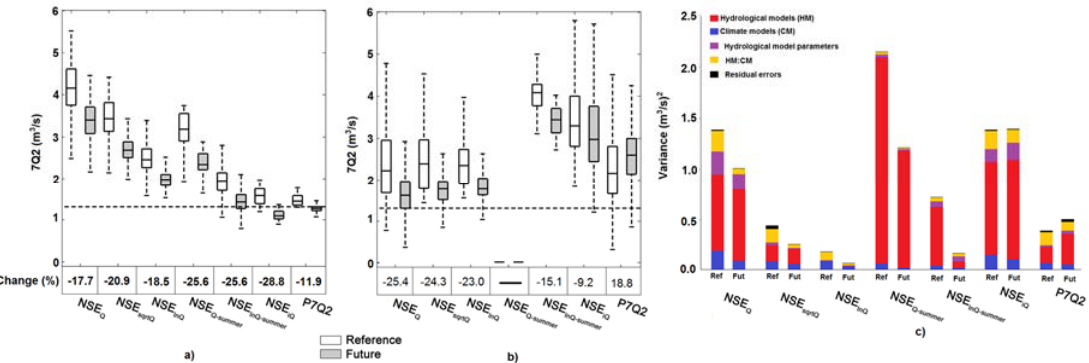
Figure 8. Uncertainties for the 7Q2 indices for the Noire River sub-watershed related to the climate model structure for the ( a ) GR4J; and ( b ) SWAT model; and ( c ) comparison of 7Q2 index variance for each source of uncertainty in reference (Ref) and future (Fut) periods for each objective functions. For the St-Hyacinthe sub-watershed, the GR4J model overestimated the 7Q2 values for the reference period for all objective functions (Figure 9a).